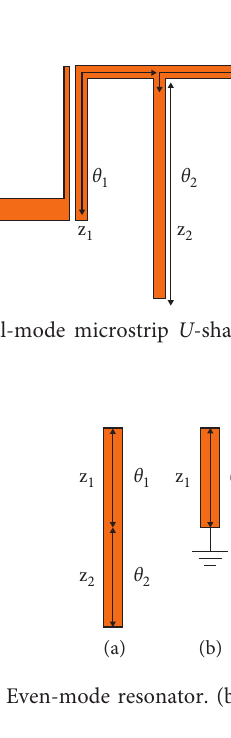
Figure 1: Topology of four-port dual-mode diplexer.